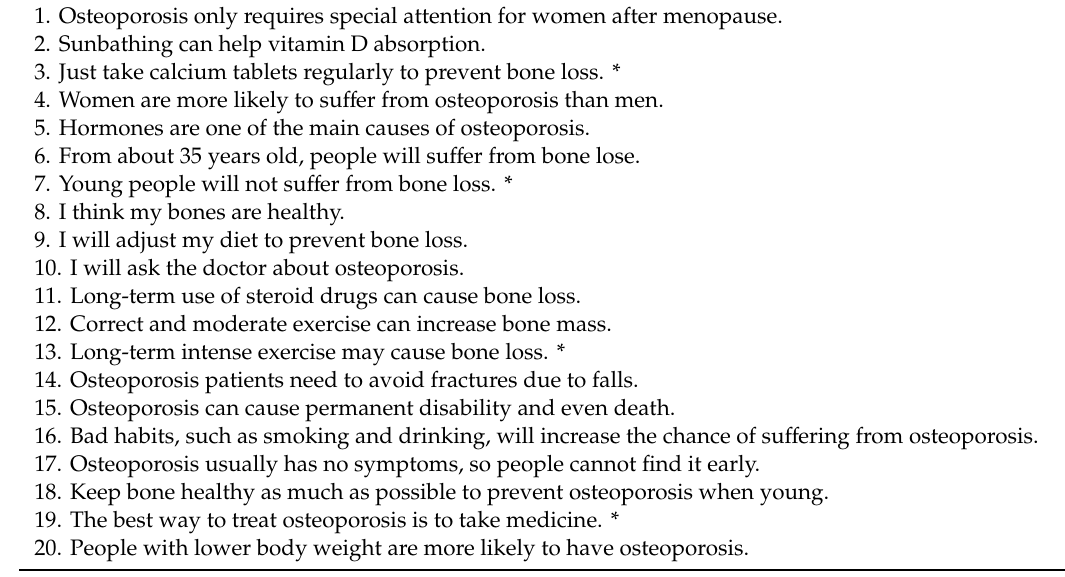
Table 1. Health literacy items of osteoporosis risks among the respondents.